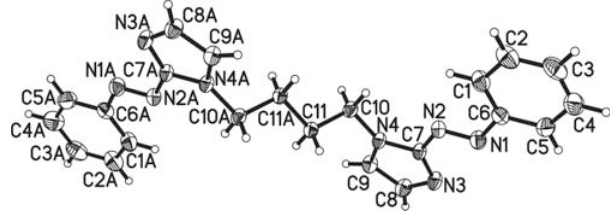
Table 1. Data collection and handling.